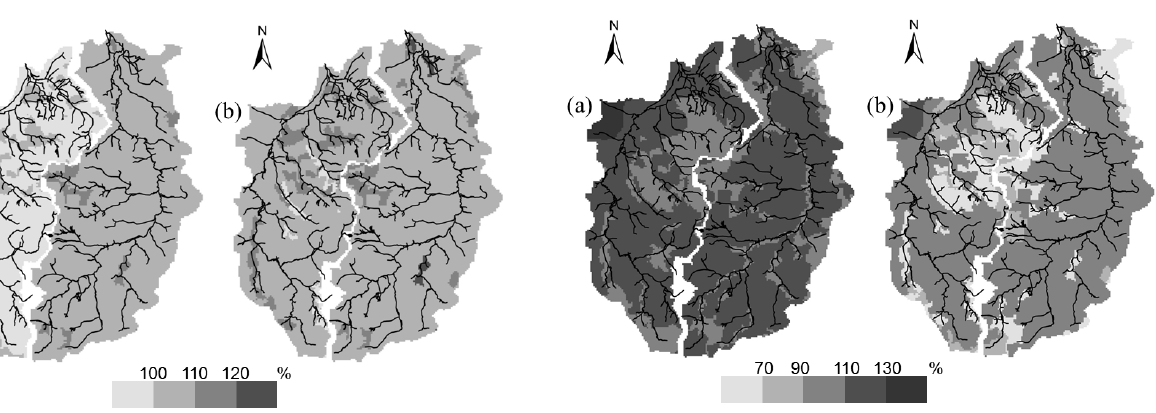
Fig. 2. Ratio between precipitation ( P ) of the scenarios and the ref- erence period, Weisser Schoeps.